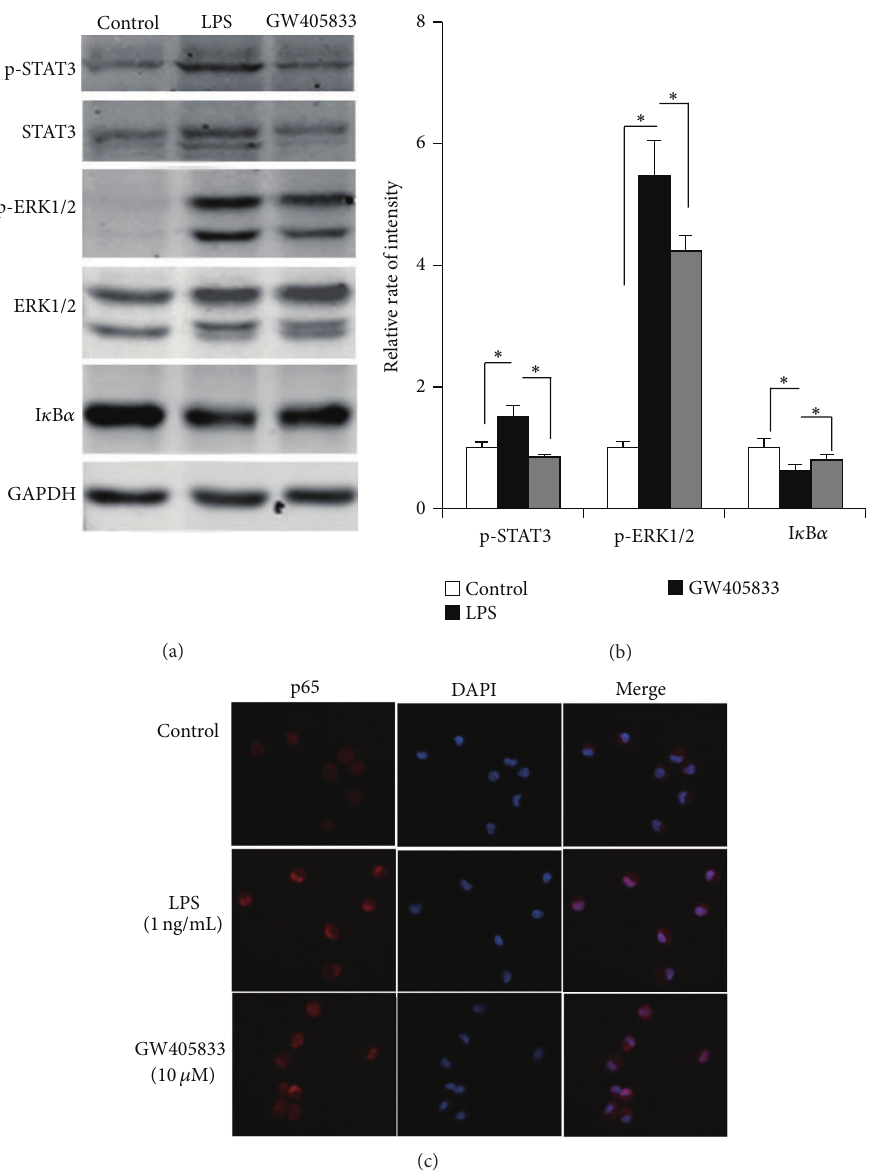
Figure 5: GW405833 inhibits LPS-triggered signal pathway in macrophages. (a) Peritoneal macrophages isolated from C57BL/6 mice were treated with vehicle or LPS (1ng/mL) in the absence or presence of GW405833 (10 𝜇 M) for 30min. STAT3, phosphorylated-STAT3, ERK1/2, phosphorylated- ERK1/2, and I 𝜅 B 𝛼 were detected by Western blotting. Data are representative of three independent experiments. (b), Quantification of the result of (a). p-STAT3 expression was normalized to STAT3, p-ERK1/2 was normalized to ERK1/2, and I 𝜅 B 𝛼 was normalized to GAPDH. Data are means ± SD, ∗ 𝑃 < 0.05 , and ∗∗ 𝑃 < 0.01 . (c) Macrophages were treated as described in (a), p65 was detected by immunofluorescence. p65 was marked in red fluorescence and nucleus was marked with DAPI in blue. Data are representative of three independent